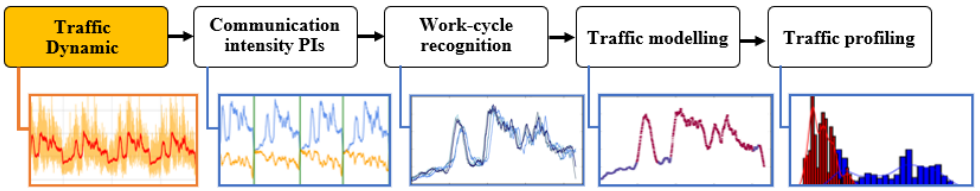
Figure 7. Overview of the proposed approach with the obtained results when applied on aggregated traffic classes